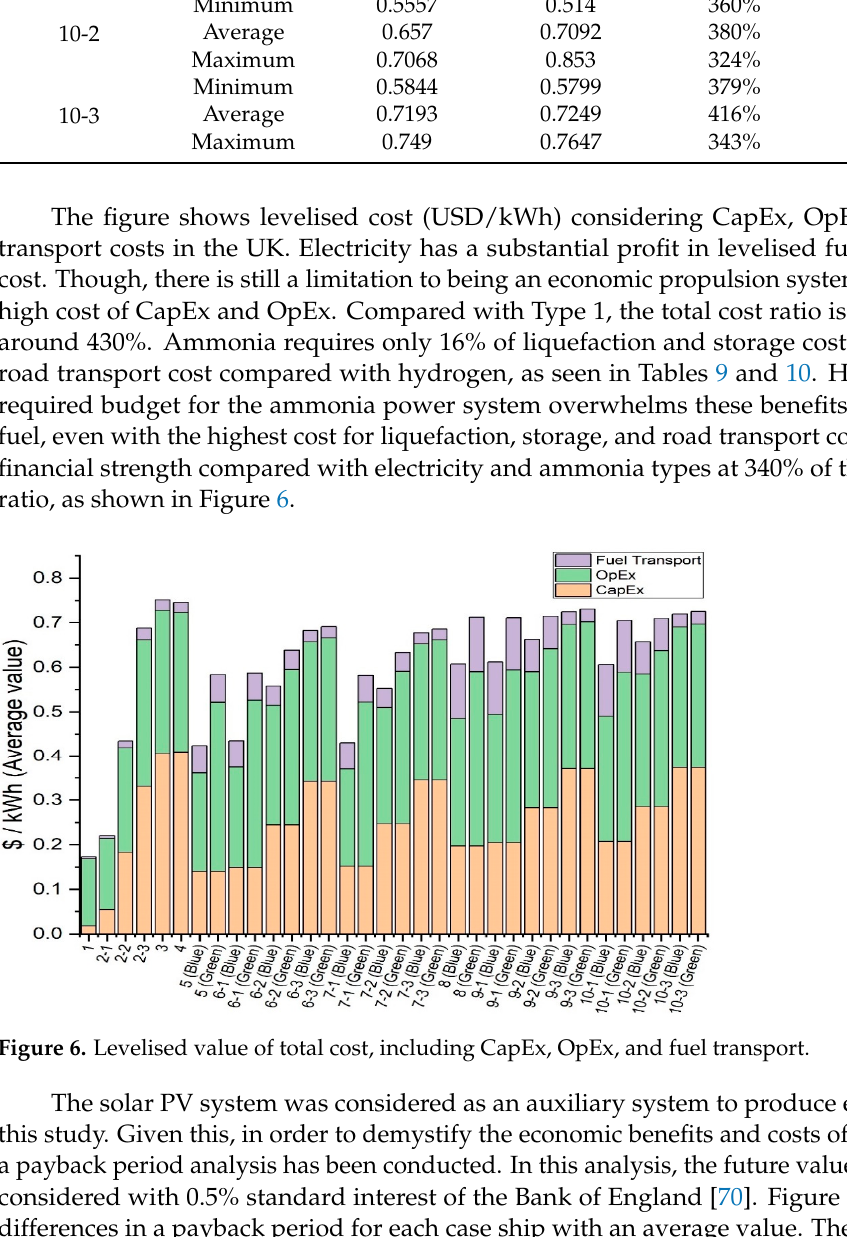
Figure 7. Payback period of solar PV system. To the cost of power sources and the operation situation of case ships, the payback period of the solar PV system was shown up to 14 years. Each ship has different solar power generation based on its operating route and the size of solar panels onboard. For example, case ships such as 14, 15, and 17 have relatively low figures for solar power gen- eration, and it causes some delays in reaching the payback period than the other case ships. The savings from operation costs are significantly influenced by the cost of power sources such as hydrogen, ammonia, and UK business electricity. Accordingly, any price change in each power source will result in different payback periods in the future.